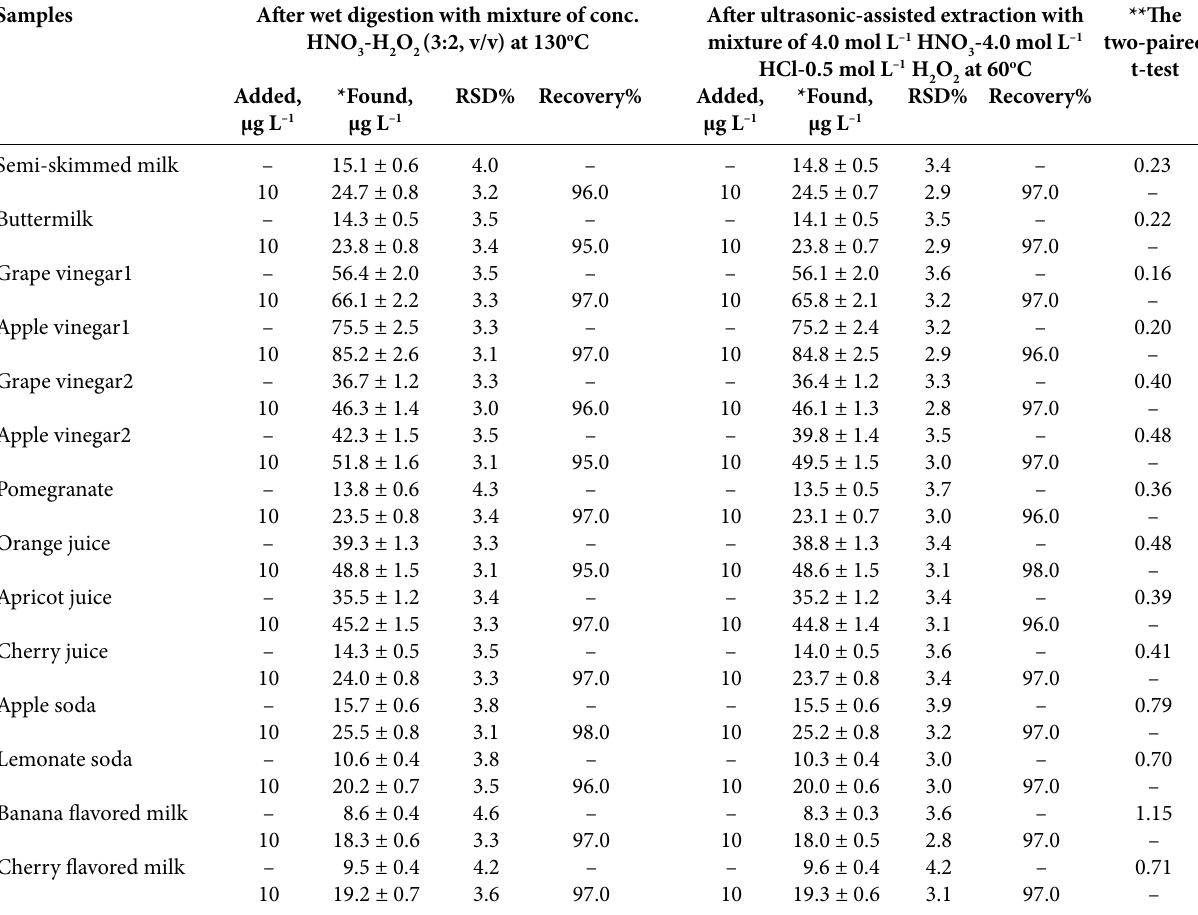
Table 4. The results of total V analysis in beverages in contact with plastic products (n: 5) Samples After wet digestion with mixture of